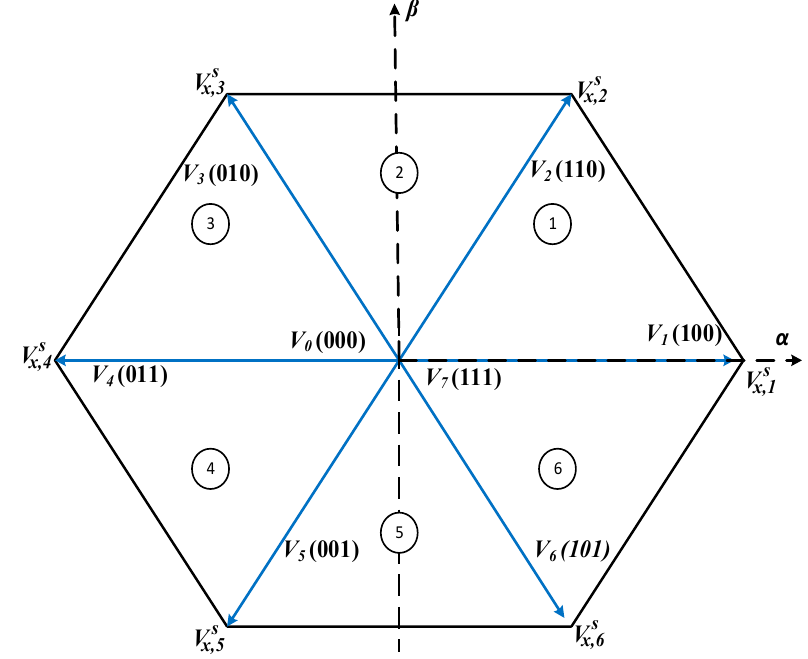
Figure 3. Different switching combinations for a two-level converter.